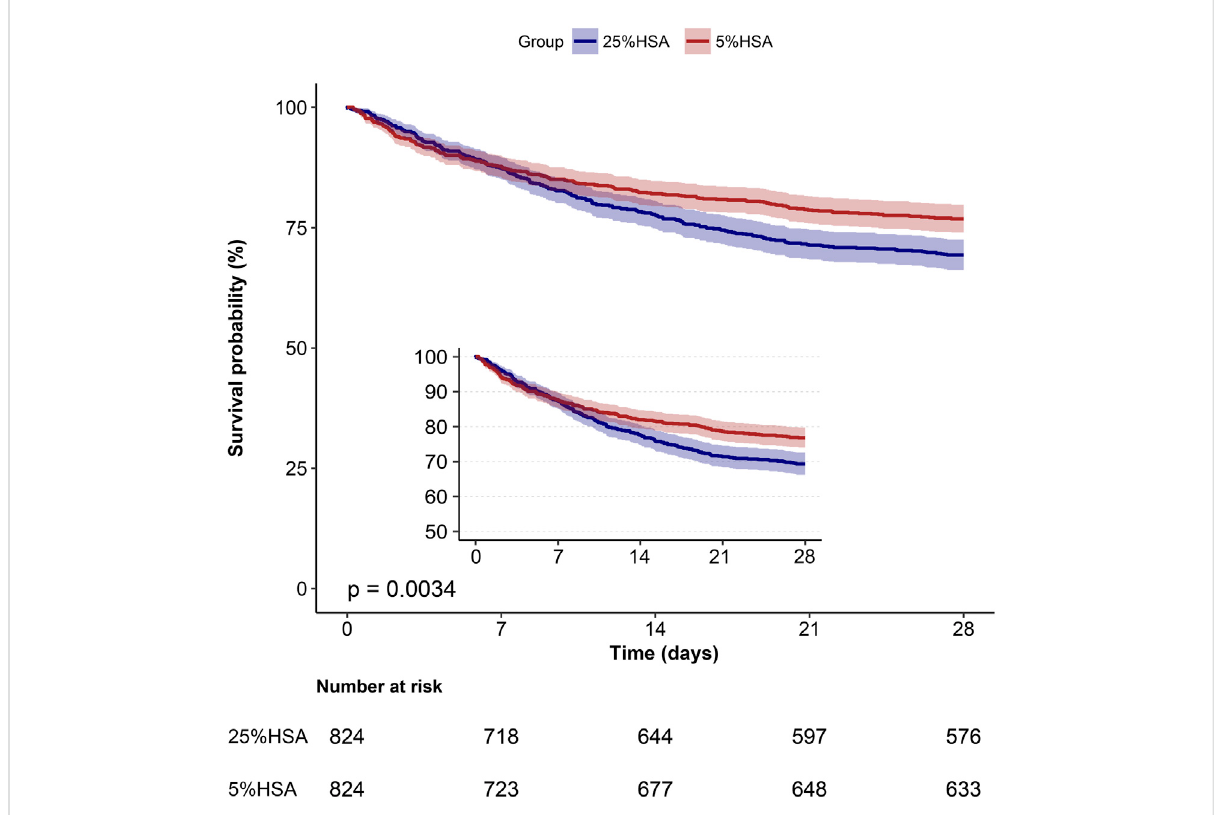
FIGURE 2 Kaplan-Meier survival curve of 28-day mortality for patients with